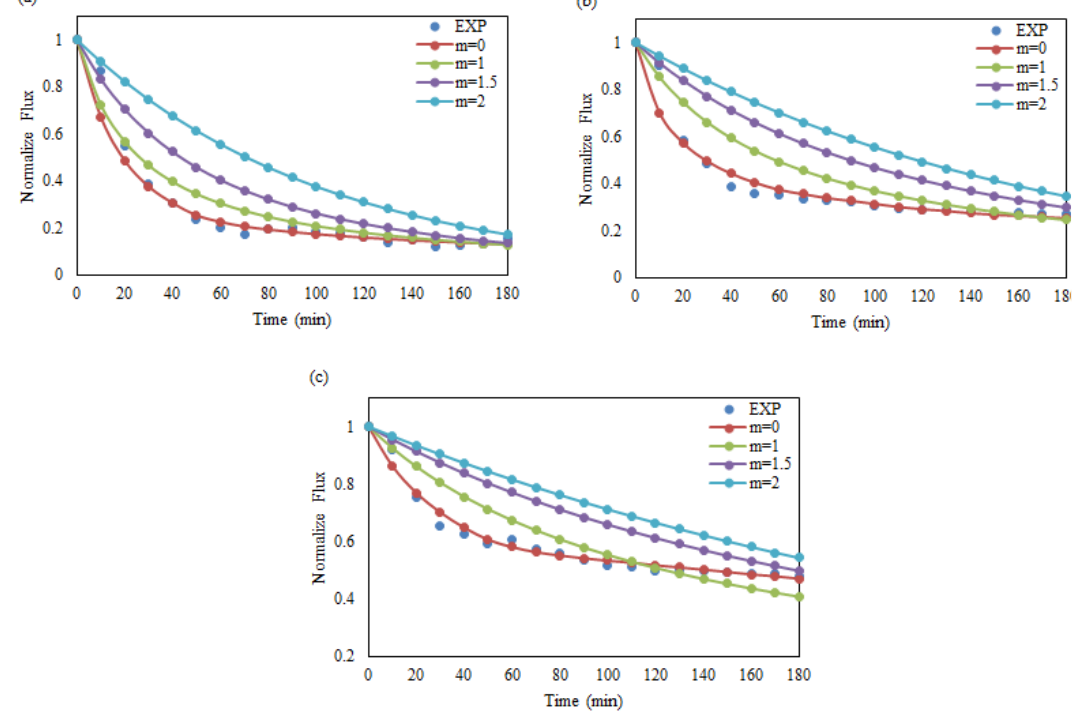
Fig. 10. Experimental data and Hermia fouling models for: (a) pure CA, (b) CA/ND (0.5 wt.%), (c) CA/ND-PEG (0.5 wt.%)